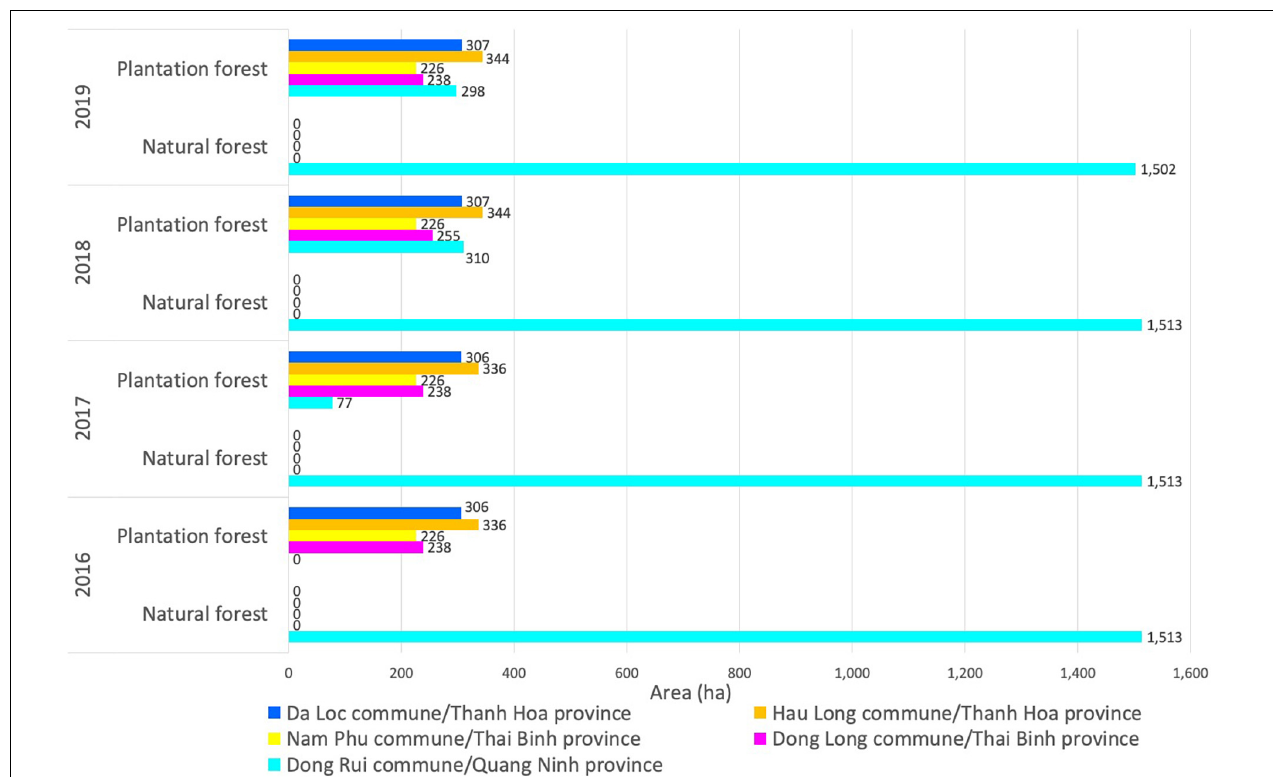
FIGURE 3 | Changes in forest area in the study communes. Source: Institute for Forest Ecology and Environment (2020).